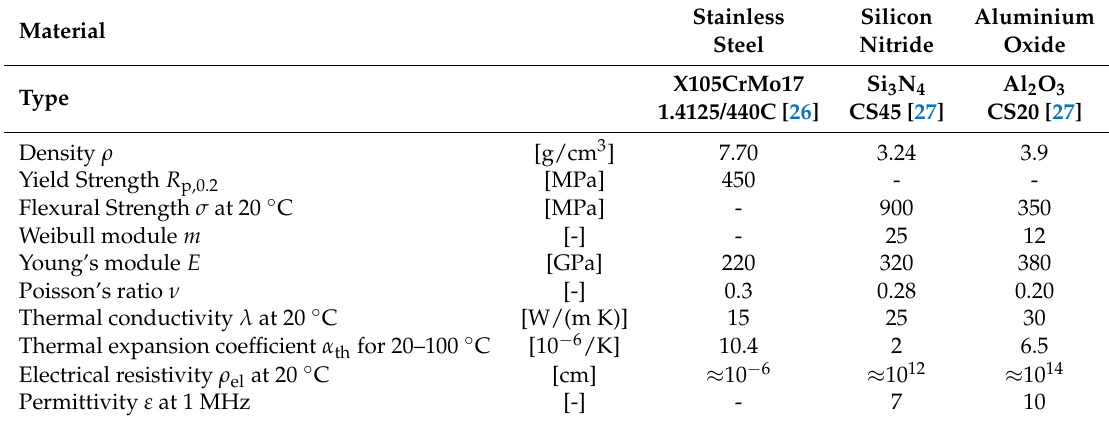
Table 4. Physical properties of potential test mandrel